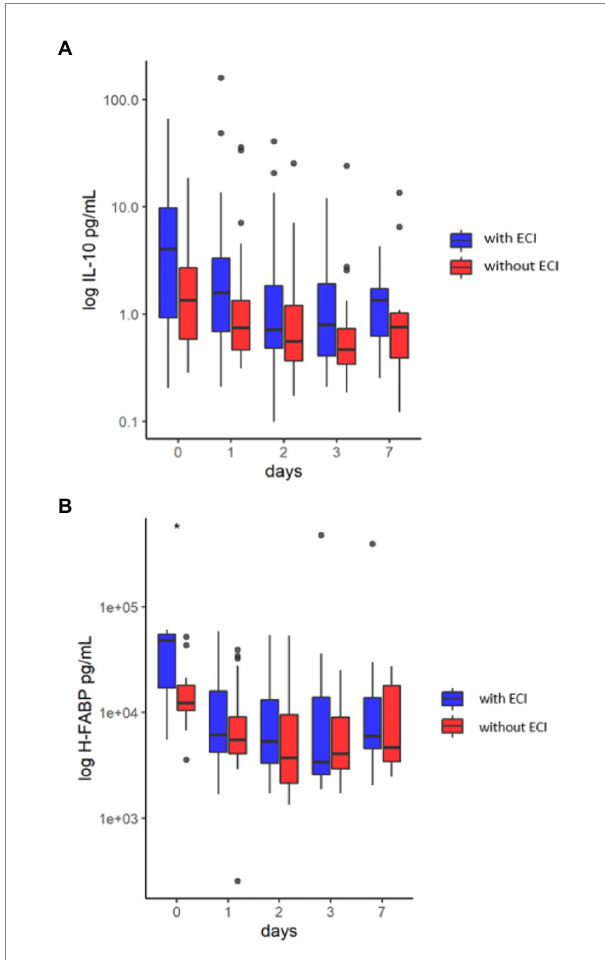
FIGURE 2 (A) Boxplot of IL-10 concentration in the first week after traumatic brain injury in the groups of patients with and without extracranial injuries. There was no significant difference in the concentration of IL-10 between traumatic brain injury patients with and without extracranial injuries. The line that divides the box into two parts is median. The bottom of the box represents first quartile (Q1) and the top of the box represents third quartile (Q3). The lower whisker represents a minimum score (excluding outliers) and the upper whisker represents a maximum score (excluding outliers). (B) Boxplot of H-FABP concentration in the first week after traumatic brain injury in the groups of patients with and without extracranial injuries. There was a significant difference in the concentration of H-FABP between traumatic brain injury patients with and without extracranial injuries on day 0 (*). The line that divides the box into two parts is median. The bottom of the box represents first quartile (Q1) and the top of the box represents third quartile (Q3). The lower whisker represents a minimum score (excluding outliers) and the upper whisker represents a maximum score (excluding outliers).